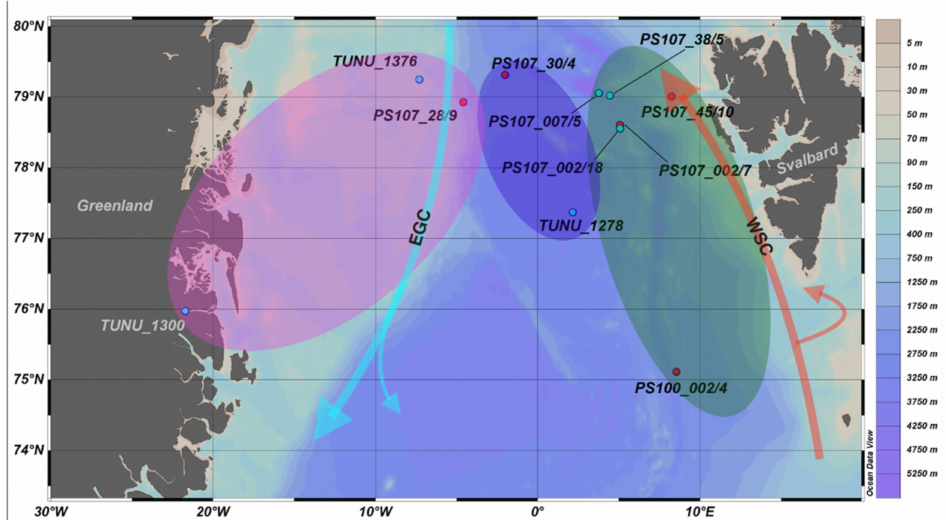
Figure 1. Sampling stations of T. libellula (blue) and T. abyssorum (red) in Fram Strait during two R/V Polarstern cruises (PS100; PS107) and a R/V Helmer Hansen cruise (TUNU) in 2016 and 2017. Circles indicate regions used for statistics assigned by geographical location: EGC (East Greenland Current and shelf) (pink), CFS (Central Fram Strait) (blue), WSC (West Spitsbergen Current) (green). Arrows indicate major currents in the Fram